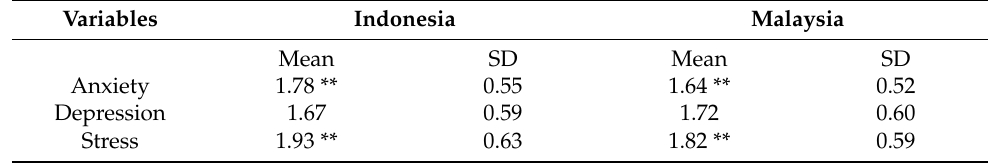
Table 5. Mean scores for anxiety, depression, and stress for Indonesia and